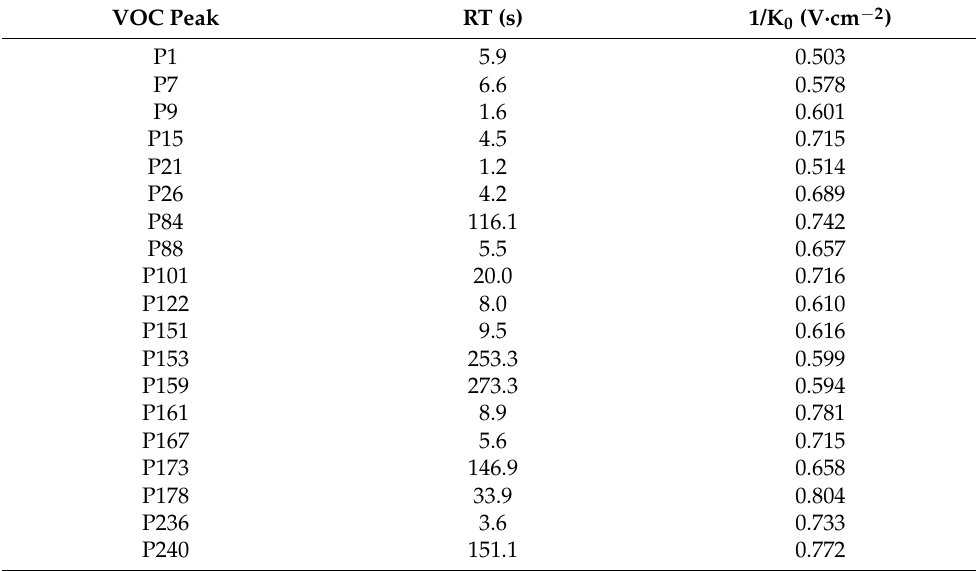
Table 1. List of volatile organic compounds (VOCs) selected as important predictor variables in the initial discovery study with their corresponding retention time (RT) and inverse reduced ion mobility (1/K 0 ). Data selected from